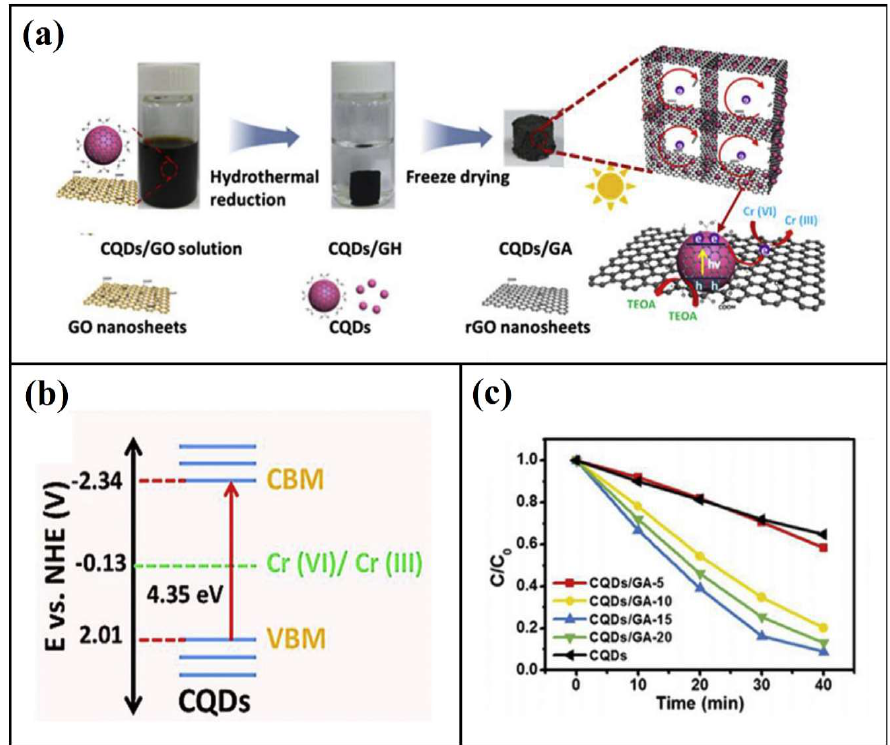
Figure 7. Carbon quantum dot graphene nano-aerogel; ( a ) the fabrication process, ( b ) band structure of carbon quantum dot, and ( c ) Photocatalytic performance of chromium (VI) reduction during UV– Vis light irradiation. Adapted with permission from Wang et al. [106] and Lee et al. [86] . In different study, magnetic carbon aerogel has been synthesized using sodium algi- nate as precursor material for the carbon and gelatin as as a cross-linker as well as second- ary carbon source [107]. The authors loaded their carbon aerogel with Fe 3 O 4 nanoparticles as magnetic component to facilitate the separation and removal of aerogel after heavy metal adsorption. The carbon aerogel had an extremely high surface area of 145 m 2 /g with variety of surface functional groups, which resulted in outstanding adsorption perfor- mance (143.88 mg/g) to Cd(II) from aqueous solutions [107]. Refer to table 3 for the sum- mary of using carbon and activated carbon nano-structured aerogels for heavy metal re- moval.